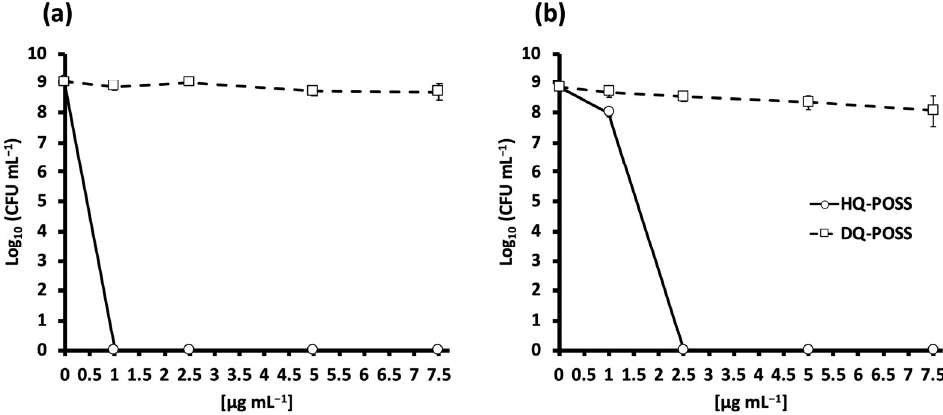
Figure 3. Kill curves of ( a ) S. maltophilia and ( b ) B. cereus experiencing increasing concentrations of HQ- and DQ-POSS.